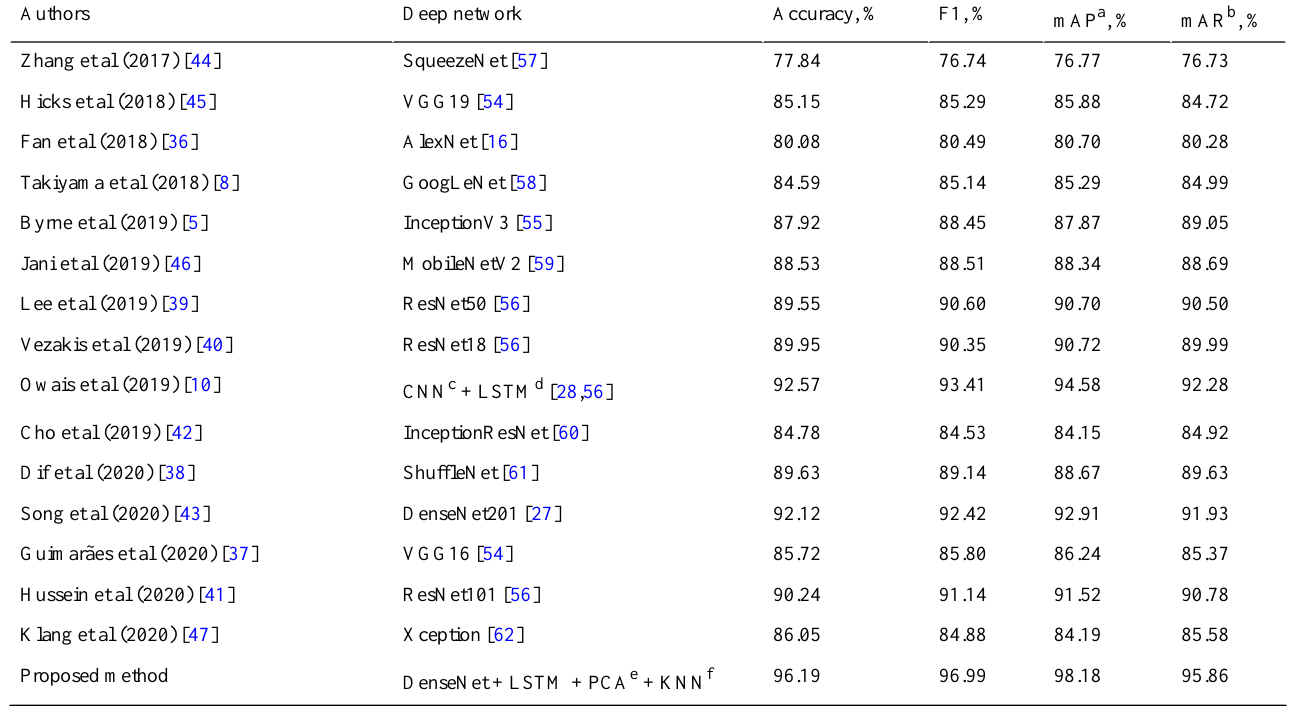
Table 2. Comparative classification performance of our proposed network with the other state-of-the-art methods used in endoscopy.